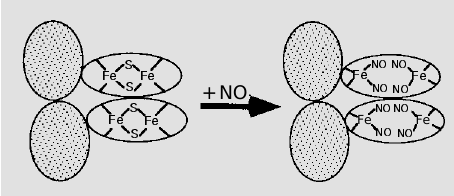
Figure 5 - Model for SoxR activa- tion by nitric oxide (NO). Reac- tion with NO converts the [2Fe- 2S] centers to nitrosylated ad- ducts. The protein is shown as a homodimer; the stippled regions correspond to the DNA-binding domains, distinct from the [2Fe- 2S]